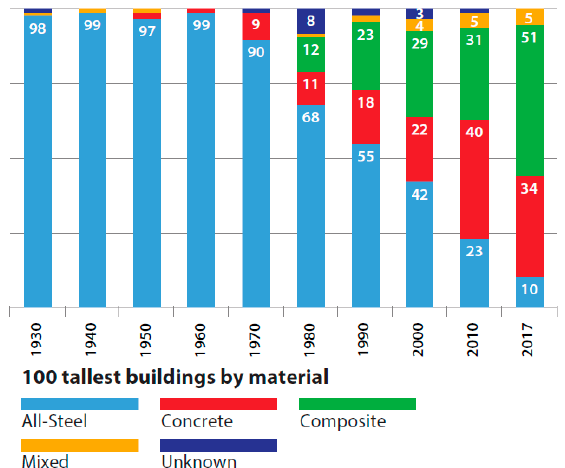
Figure 13. 100 tallest buildings by material (Source: CTBUH).